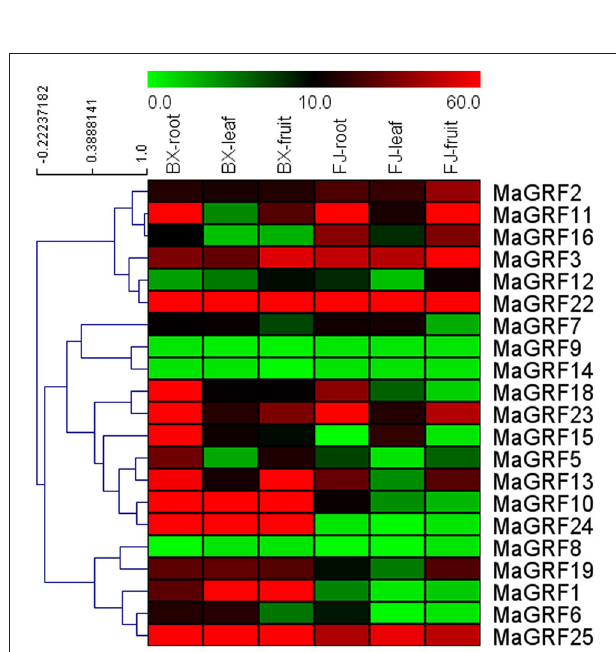
FIGURE 5 | Expression analysis of banana 14-3-3 genes in roots, leaves, and fruits of two cultivated banana varieties. Banana leaves and roots at the five-leaf stage and fruits at 80 DAF in the BX and FJ varieties were sampled to detect the expression profiles of 14-3-3s in various tissues. The heat-map was created based on the transcriptomic data of 14-3-3s from two independent experiments. The scale represents relative signal intensity